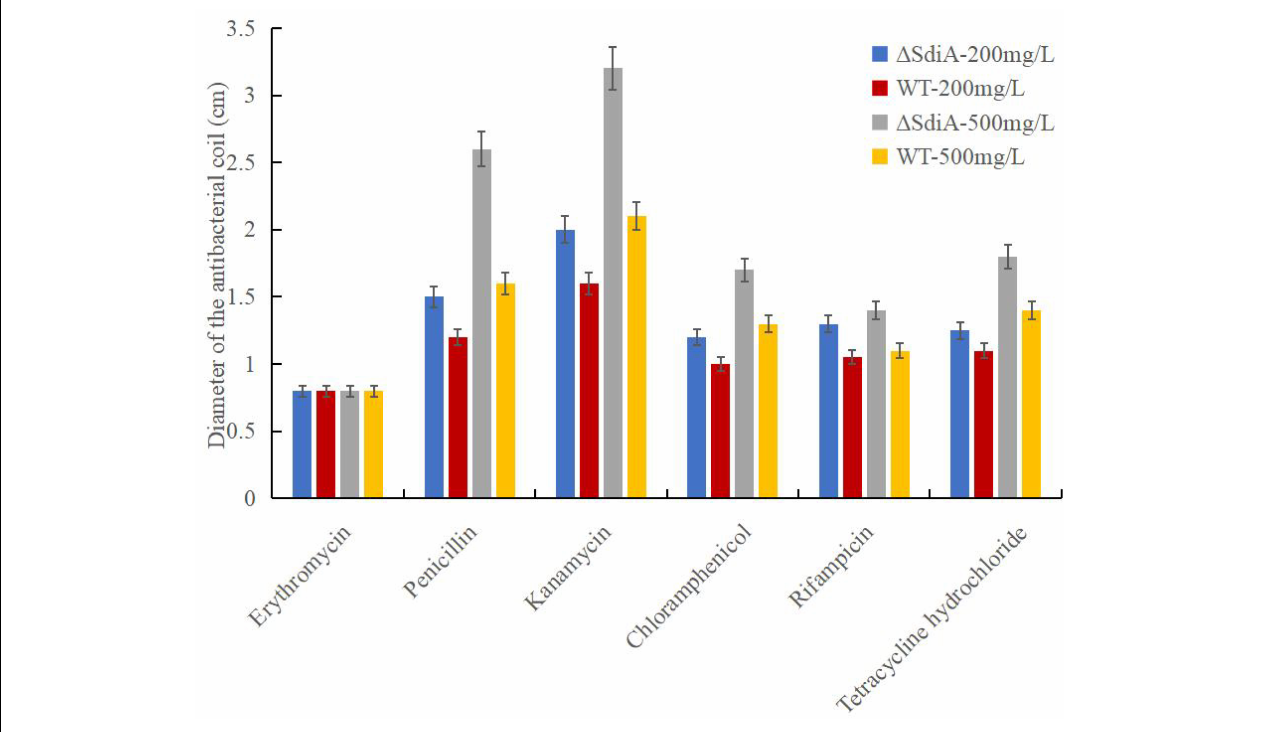
FIGURE 5 | Cronobacter sakazakii WT and (cid:49) sdiA mutant strains antibiotic resistance assay. Error bars represent standard deviation. All experimental data’s were plotted as mean ± standard from triplicate determinations and statistical analysis was performed with SPSS 18.0 Significance of WT and (cid:49) sdiA mutant strains were established through t -test using P values <